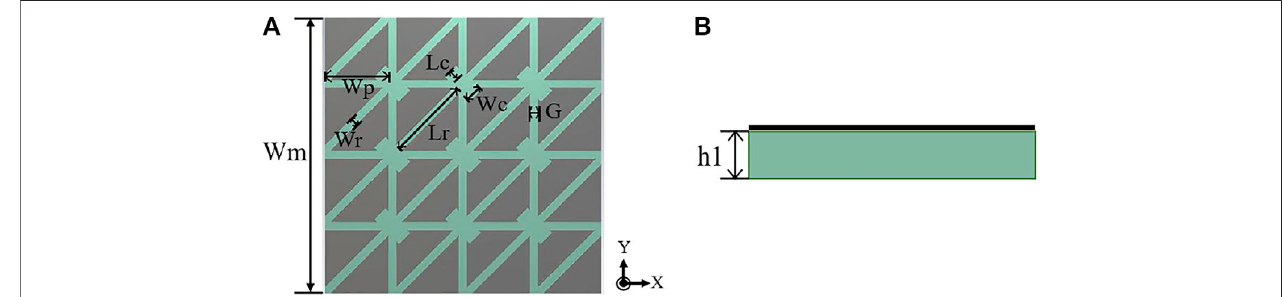
were both narrow. In [9], a metasurface antenna composed of square metal patch units was proposed, and four intersecting slots were used for slot coupling feed through the microstrip line. The antenna achieved the 3 dB ARBW of 14.5%, and the axial ratio